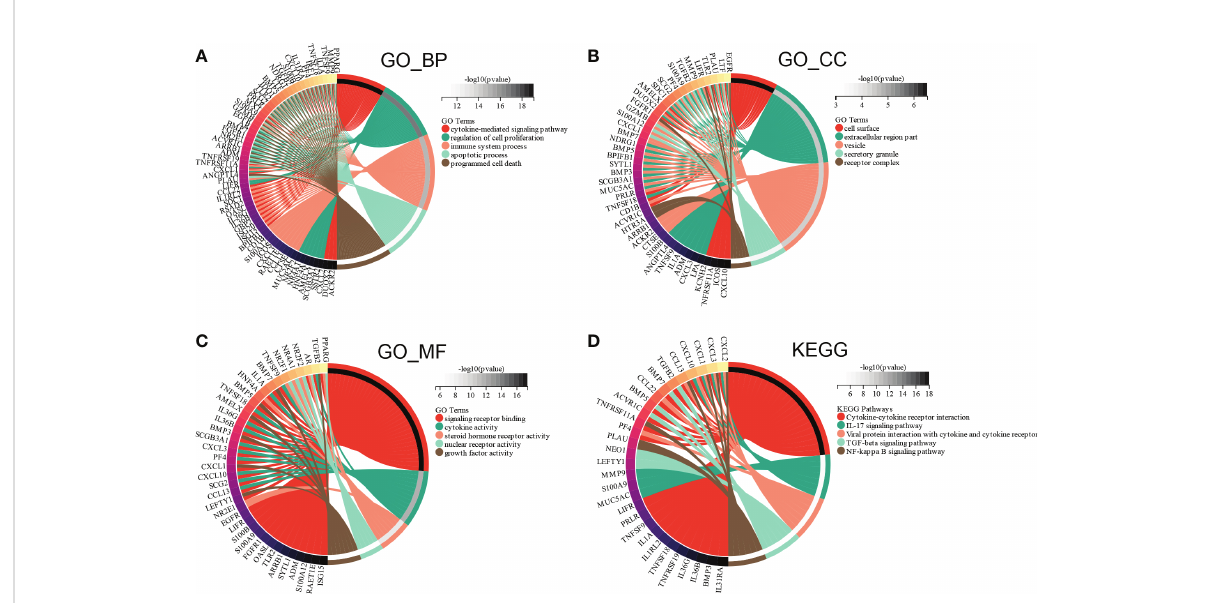
FIGURE 10 Functional enrichment analysis of ceRNA Network. (A) biological process, (B) molecular function (C) cell composition and (D) KEGG analysis results of differentially expressed immune-related genes between high and low E6ratio